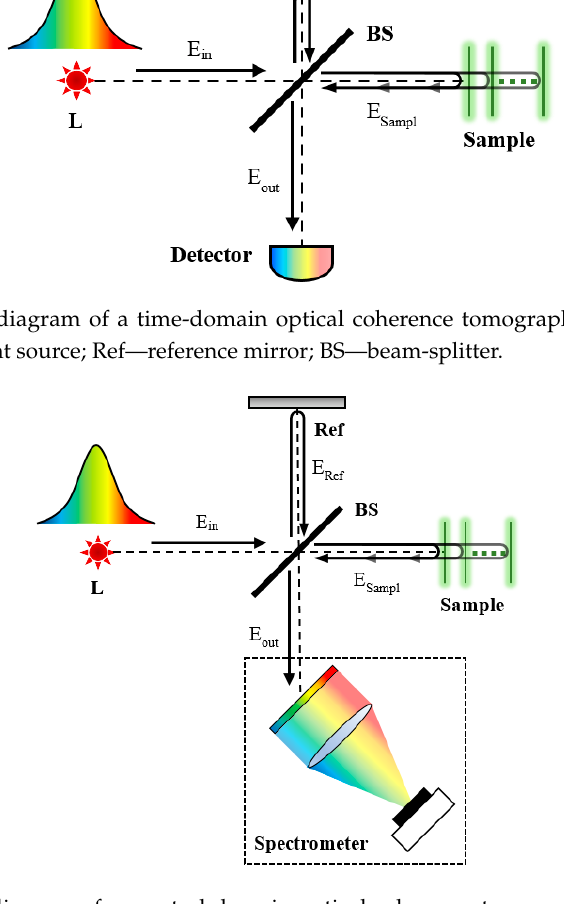
Figure 2. Schematic diagram of a spectral-domain optical coherence tomography SD-OCT system. L—low-coherence light source; Ref—reference mirror; BS—beam-splitter.